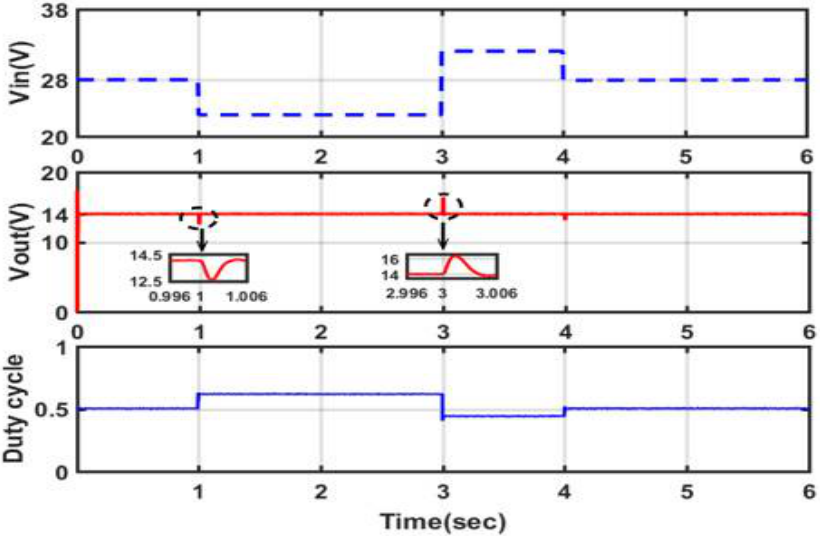
Figure 11. Changes in output voltage and duty cycle with an RST controller in response to input voltage variation.